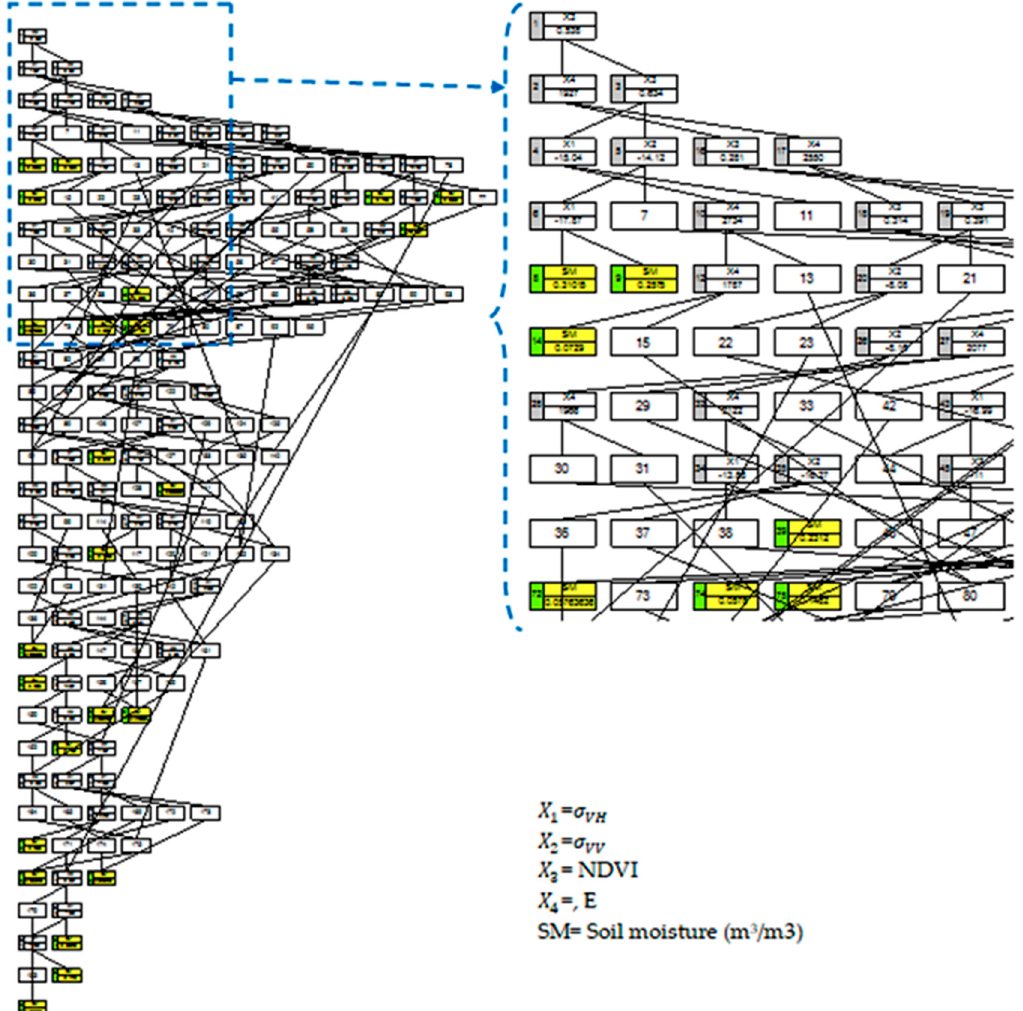
Figure 6. The optimal SCA tree with α = 0.01 for FLDAS Noah soil moisture. The total nodes and tip clusters are 185 and 24, respectively. Note that parts of the SCA tree are zoomed in just to show the links among variables and the yellow boxes indicates the tip clusters. The high resolution copy of this figure is provided as supplementary information.